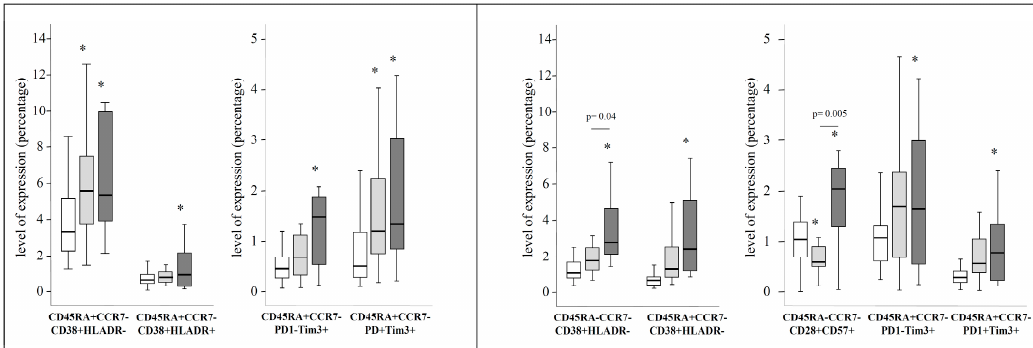
Figure 3. Box-plots showing differences in the level of expression for several CD4 (left graphs) and CD8 (right graphs) T-cell subsets between HIV monoinfected patients (white boxes), pre-DAAs HIV/HCV coinfected patients with liver stiffness (LS) < 7.1 Kpa (light-grey boxes) and in pre-DAAs coinfected patients with LS ≥ 7.1 KPa (dark-grey boxes). p -values for the comparison between HIV / HCV with LS < 7.1 Kpa and LS ≥ 7.1 KPa are shown. An asterisk (*) indicates significant ( p < 0.05) di ff erence compared to HIV monoinfected patients by Mann-Whitney U